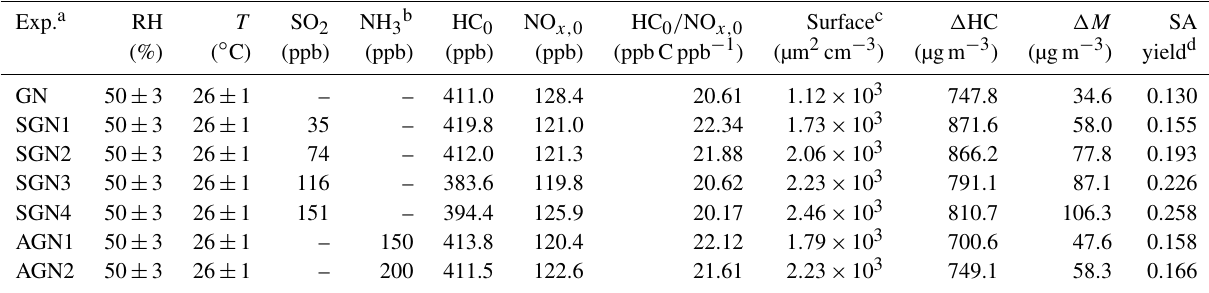
Table 1. Summary of experimental conditions in this study.